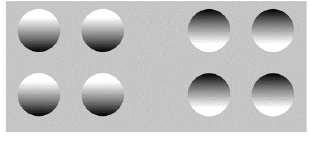
Figure 1. The circles on the left are illumated from above, and appear as bumps, whereas the circles on the right are illuminated from below and appear as craters. The Figure is recreated from Ramachandran,